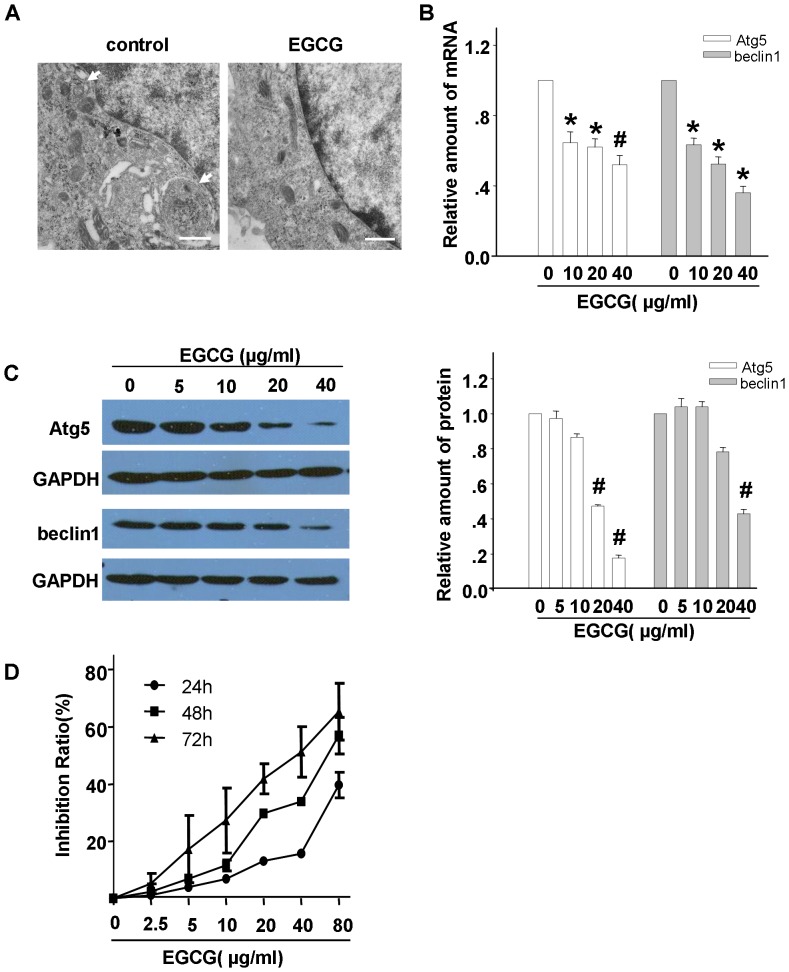
Dose-dependent inhibited effect of EGCG on the autophagy and proliferation in Hep3B cells.(A) EGCG (40 µg/ml) was found to reduce the autophagosome number in Hep3B cells. Arrows indicate autophagic structures. (B) Exposed to EGCG of 10, 20, 40 µg/ml for 24 h, the expression levels of Atg5 and beclin1 in Hep3B cells were determined at the RNA levels by qRT-PCR. (C) Cell lysates following treatment with varies concentrations of EGCG were subjected to western blotting. Protein ratios normalized to GAPDH were used to quantify fold change relative to control. Results shown are representative of three independent experiments and error bars indicate SE. (D) EGCG exerted inhibition effects on proliferation of Hep3B cells in dose- and time-dependent manner after EGCG treatment with the indicated concentrations. Bars = 500 nm. Magnification, ×40000. *p<0.05 vs. control, #p<0.01 vs. control.